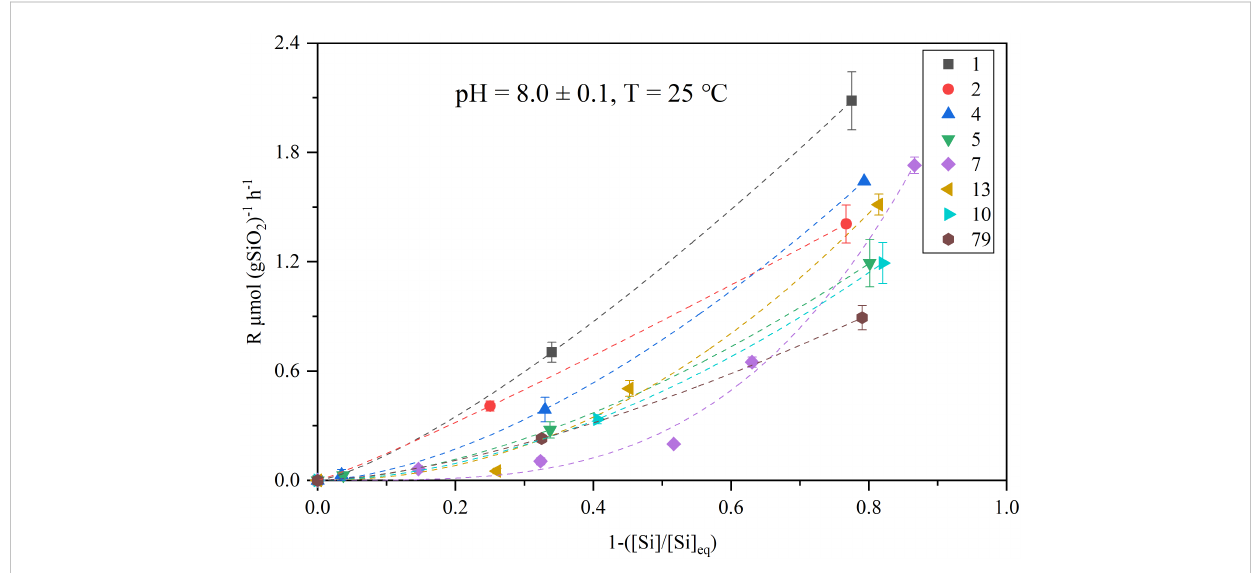
FIGURE 10 Experimental dissolution rates [ m mol (gSiO 2 ) -1 h -1 ] plotted versus the departure from equilibrium. The dashed line is the curve fi tted by the experimental data using Eq. (2). The legends ansssd numbers in the upper right corner indicate different stations conducted fl ow-through experiments. The uncertainties are shown by error